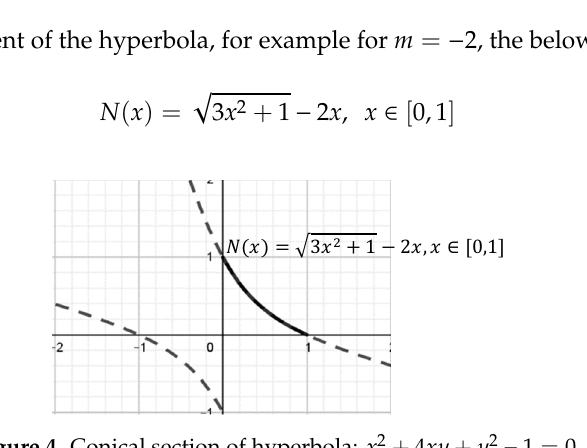
6 of 7 Figure 2. Strong negation via line. 4.3. Strong Negation via Ellipse If −1 < 𝑚 < 0, Equation (11) takes the form: 𝑥 (cid:2870) + 𝑦 (cid:2870) − 2𝑚𝑥𝑦 − 1 = 0, 𝑥, 𝑦 ∈ [0,1] (18) 𝑁(𝑥) = (cid:3493)(𝑚 (cid:2870) − 1)𝑥 (cid:2870) + 1 + 𝑚𝑥, −1 < 𝑚 < 0, 𝑥 ∈ [0,1] , (19) which represents a segment of an ellipse, for example for 𝑚 = − (cid:2869) (cid:2870) , the below negation is the result, see Figure 3. 𝑁(𝑥) = (cid:3495)− (cid:2871) (cid:2872) 𝑥 (cid:2870) + 1 − (cid:2869) (cid:2870) 𝑥, 𝑥 ∈ [0,1] Figure 3. Conical section of ellipse: 𝑥 2 + 𝑥𝑦 + 𝑦 2 = 1